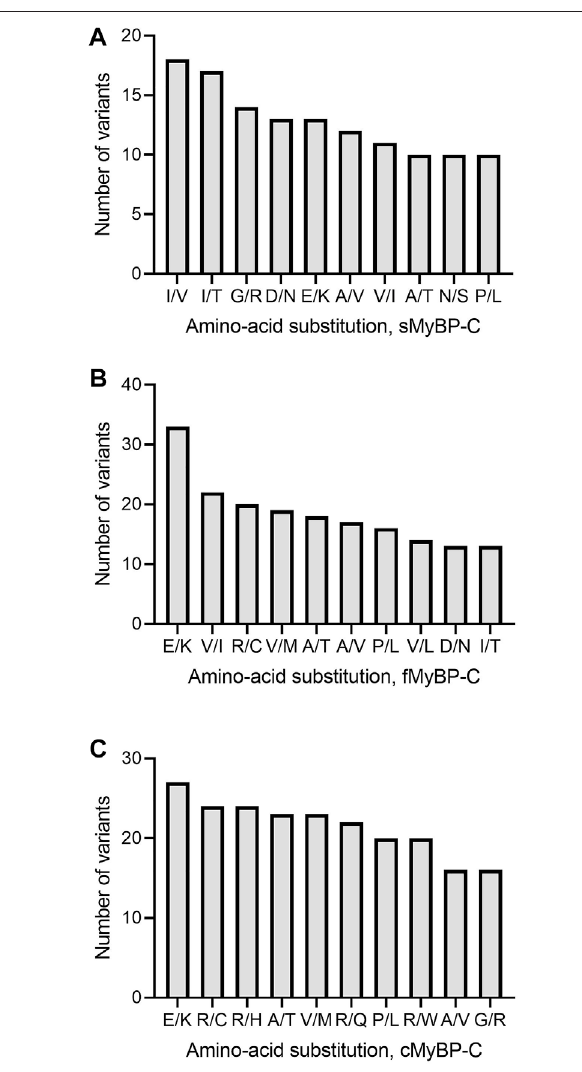
FIGURE 4 | Top ten most frequent amino acid substitutions in the MyBP-C paralogs. E > K and A > T are the most common amino acid substitutions across paralogs. I/V, V/I and R/C are most frequent amino acid substitutions in sMyBP-C (A) , fMyBP-C (B) and cMyBP-C (C) , respectively.